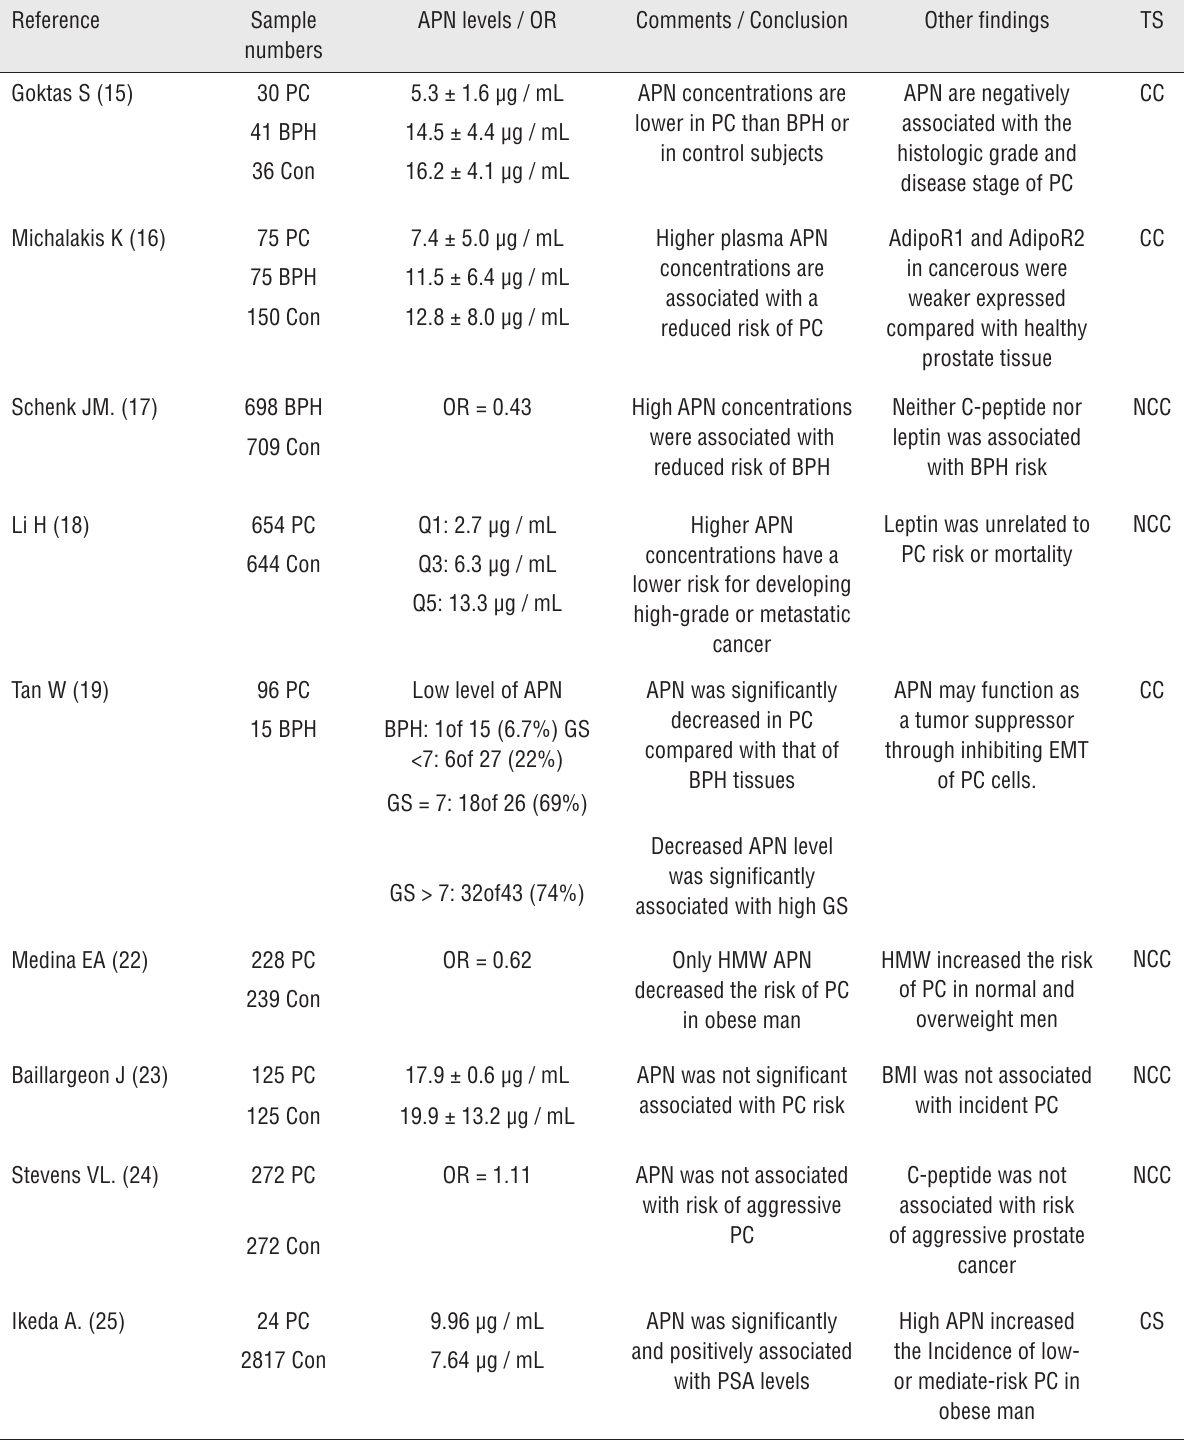
Table 1 - Recent Studies showing the association between APN concentrations and risk of